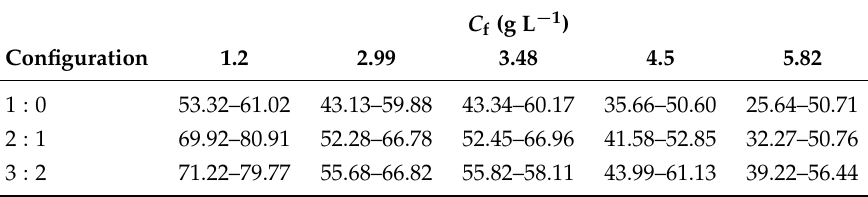
Table 3. R (%) range for different BWRO configurations and five C f (samples 20, 5, 22, 3 and 11 (Table